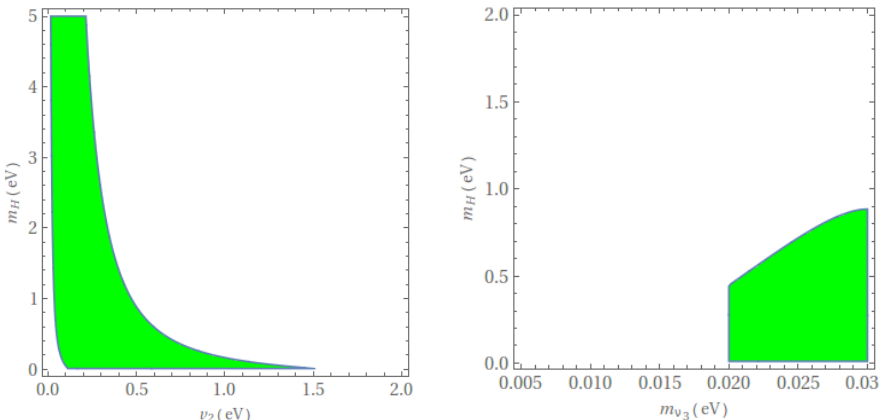
Figure 2 . Parameter region satisfying the allowed range of (cid:28) (cid:23) neutrino decay (cid:23) 1 ! 3 (cid:23) 3 , a. in v 2 (cid:0) m H plane with m (cid:23) (cid:0) m H plane with v 2 = 0 : 5 eV, m (cid:23) m (cid:23) 3